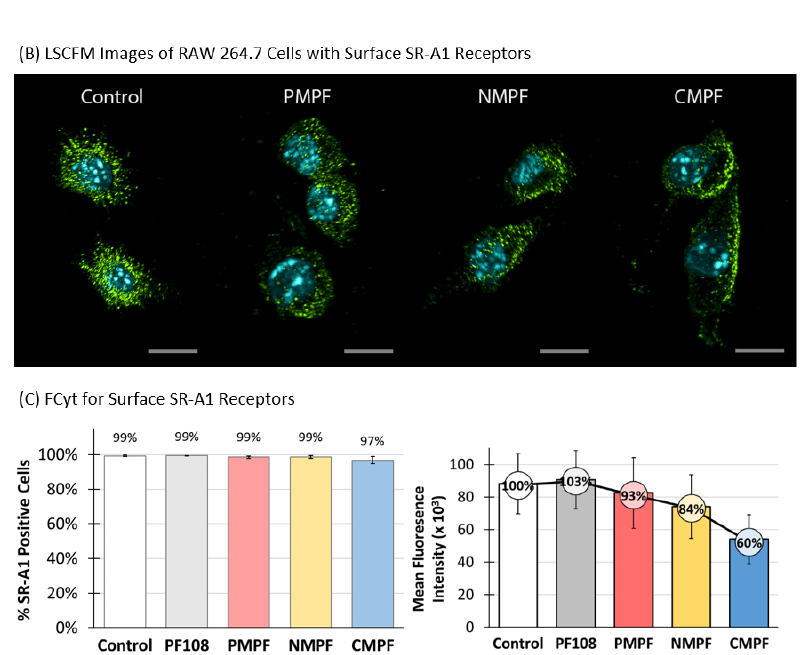
Figure 5. Effects of MWNT accumulation on surface SR-A1 receptor expression in RAW 264.7 cells. RAW 264.7 cells were incubated in media containing 0.1 mM PF108 alone or 100 µg/mL of P-, N-, or CMPF at 37 °C for 24 h. Cells incubated in regular culture medium in the absence of PF108 and MWNTs are the untreated control. Cells were washed and chased in fresh medium at 37 °C for 1 h to promote internalization of MWNTs that may have been on the cell surface. SR-A1 on the cell surface was immunologically detected by either FCyt or LSCFM as described in Methods. Briefly, cells were detached from culture plates with enzyme-free buffer, washed, chilled on ice, and appropriate antibodies were added to cells at 4 °C to prevent internalization of receptors or ligands. ( A ) The timeline scheme outlines the key experimental steps. ( B ) Representative Laser Scanning Confocal Fluorescence Microscopy (LSCFM) images of untreated control and MWNT-treated cells. Blue fluorescence is emitted from Hoechst 33342 stained nucleus and green fluorescence is from Alexa Fluor ® 488-conjugated SR-A1 receptors. Scale bars are 10 µm. ( C ) The fraction of positive cells out of a total 20,000 analyzed by flow cytometry was expressed as the % of positive for surface SR-A1 (left panel). The surface SR-A1 receptor expression level is represented as the mean fluorescence intensity of 20,000 cells analyzed per sample (right panel). Percent values inside circles are the mean fluorescence intensity relative to untreated control where the surface SR-A1 receptor level was set to 100%. Data are the mean ± SD of triplicate measurements per sample in ≥3 independent experiments. Representative LSCFM images of cells stained with Alexa Fluor ® 488-conjugated mAbs for SR- A1 and Hoechst dye for the nucleus are shown in Figure 5B. Green fluorescence marking surface SR- A1 was in punctate spots, noted previously and attributed to the localization of SR-A1 in lipid rafts